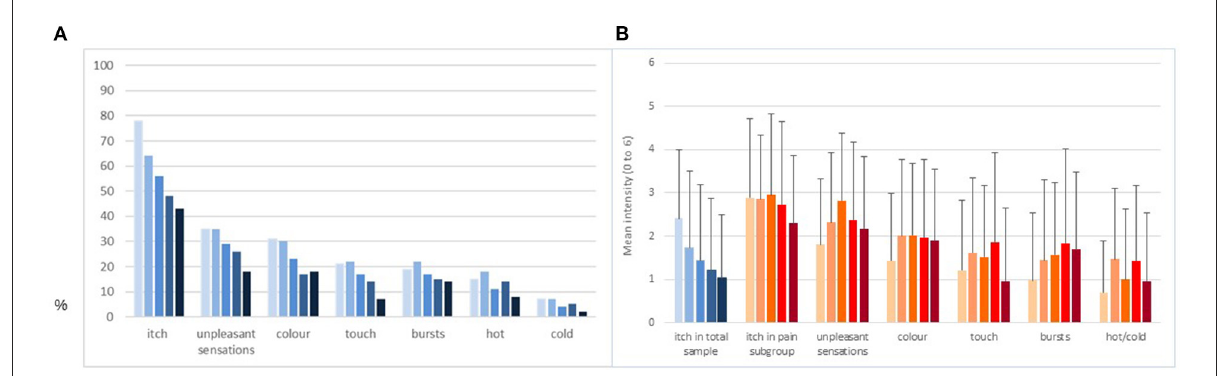
FIGURE1 Prevalence rates and observed means of itch intensity and neuropathic pain symptom intensity in complete cohort. (A) Percentage of patients indicating the symptom was present. (B) Observed means of intensity and standard deviations of the symptoms scored on a 7-point Likert scale. Bars from left to right represent the five time points from 2 weeks post discharge (T1, n = 177), 3 (T2, n = 166), 6 (T3, n = 156), 12 (T4, n = 155), and 18 (T5, n = 146) months post-burn. Blue bars relate to the total sample. Orange bars relate to the subsample experiencing neuropathic pain symptoms.